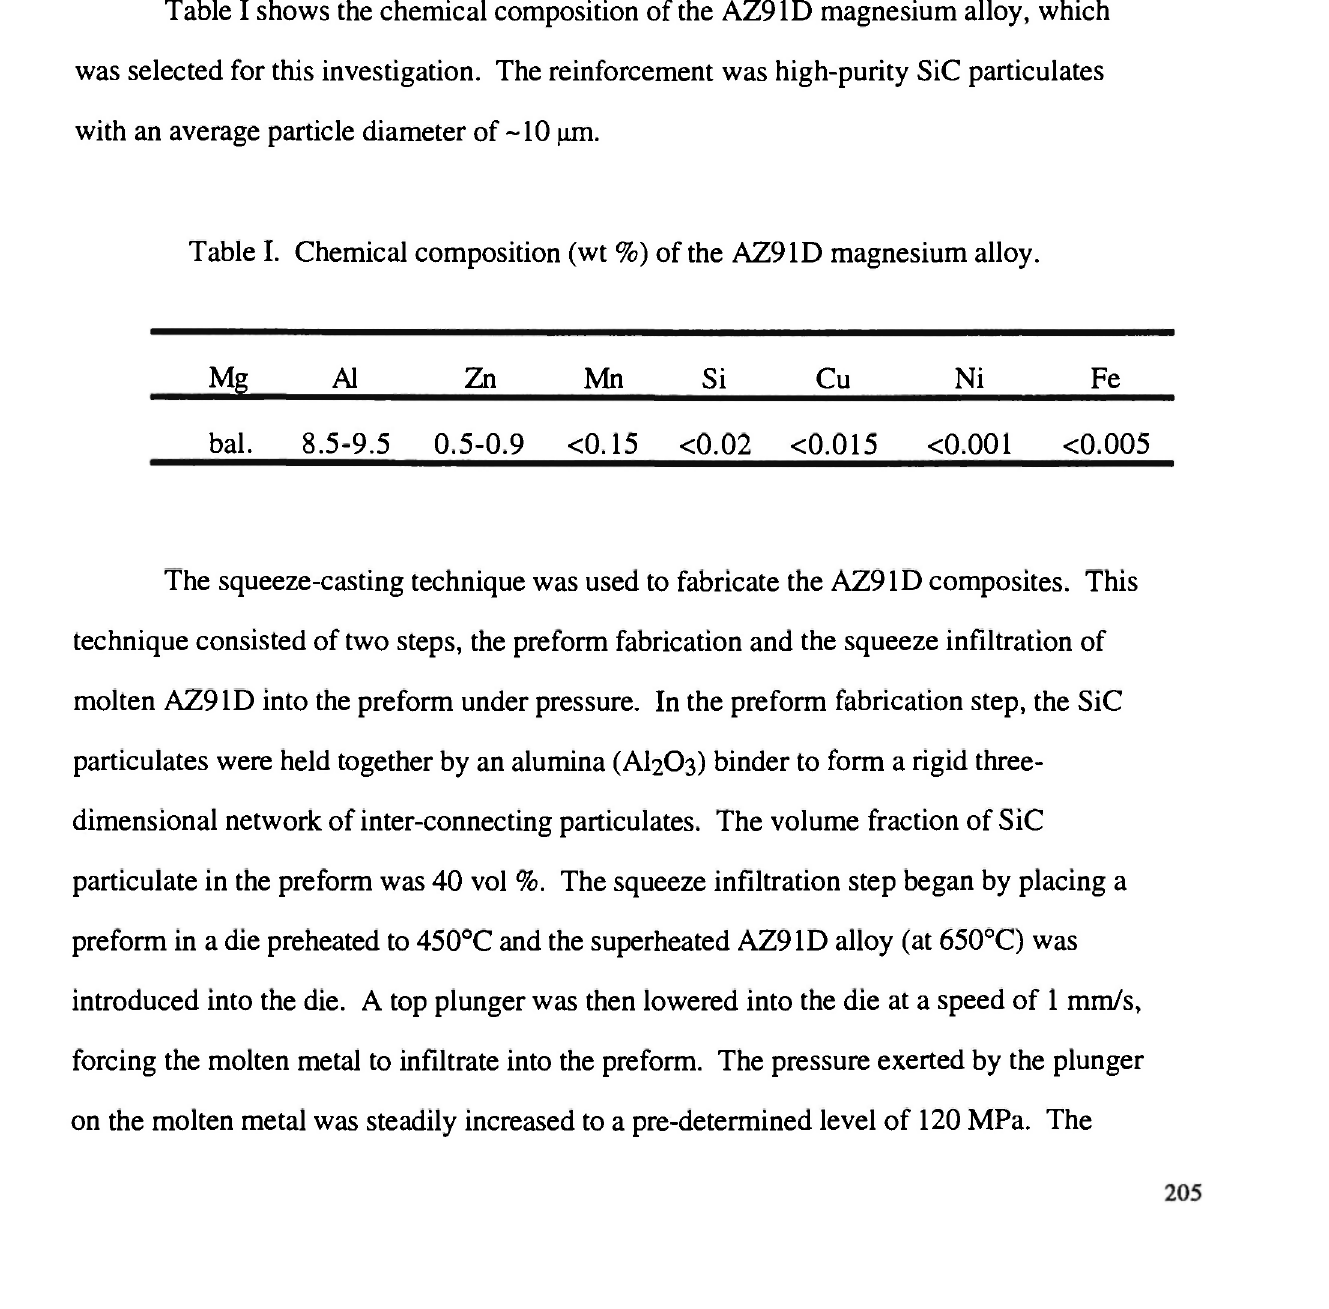
Table I. Chemical composition (wt %) of the AZ91D magnesium